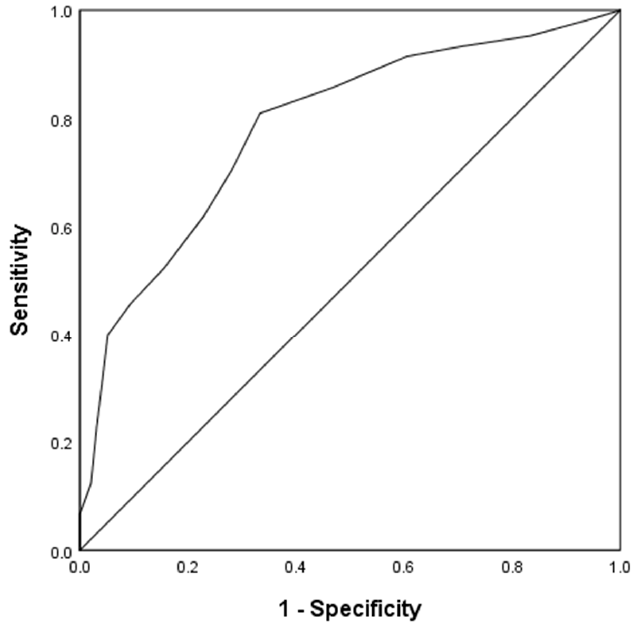
Figure 2. Receiver operating characteristics (ROC)